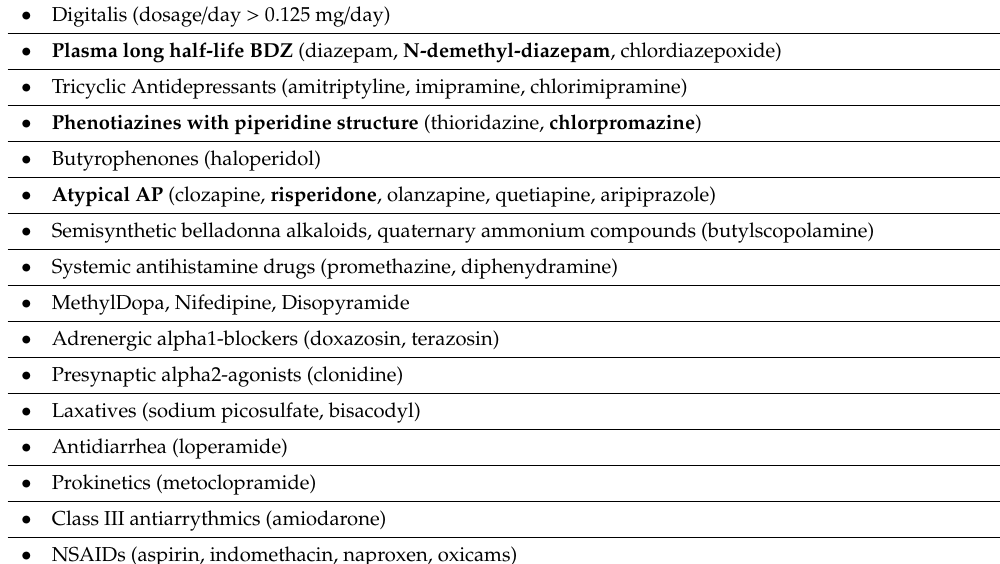
Table 4. Inappropriate drugs according to the Beers criteria [11]. Drugs in bold were being taken by our